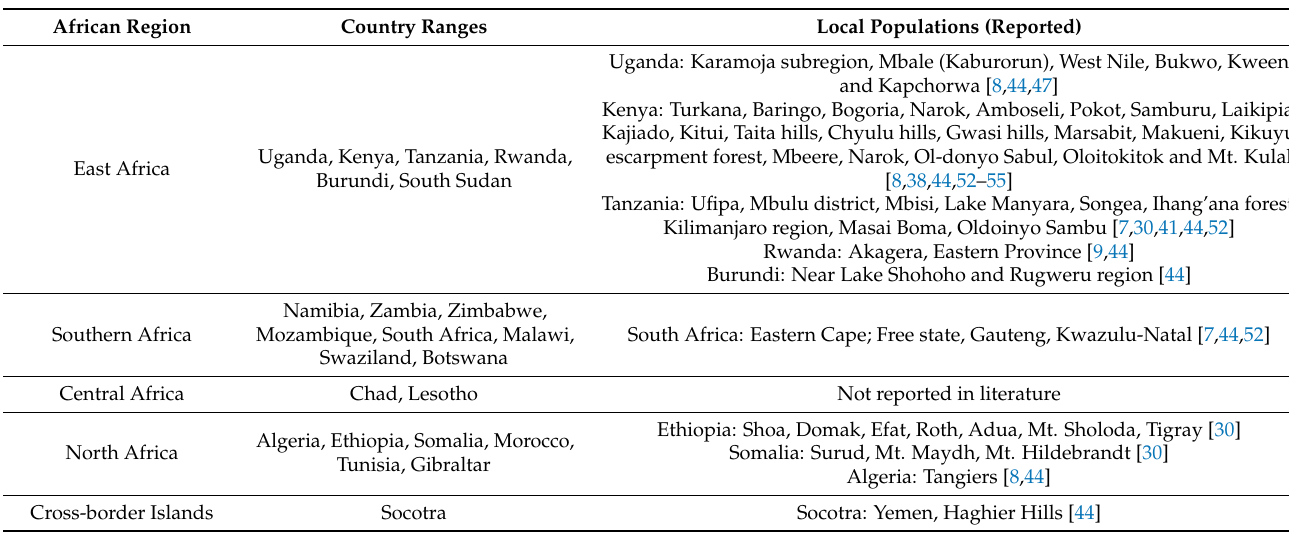
Table 2. Country range distribution of Osyris lanceolata in Sub-Saharan